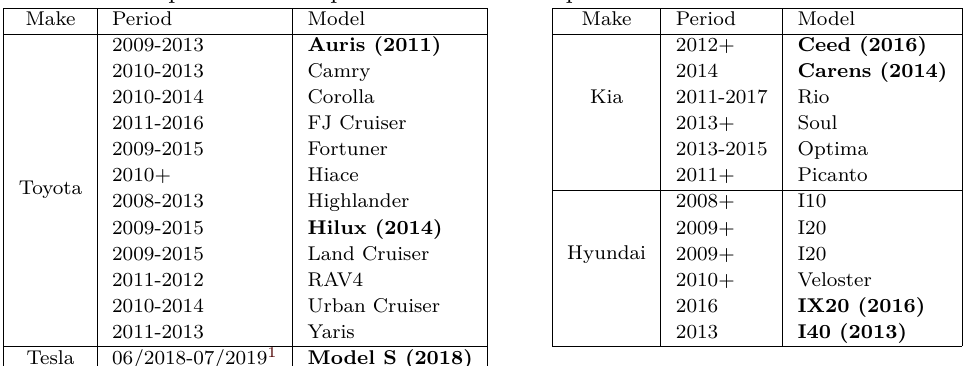
Table 1: Non-exhaustive list of vehicles affected by the research in this paper. The indicated production period is based on the information available in [traa, trab]. The models in bold point out the specific vehicles we inspected.